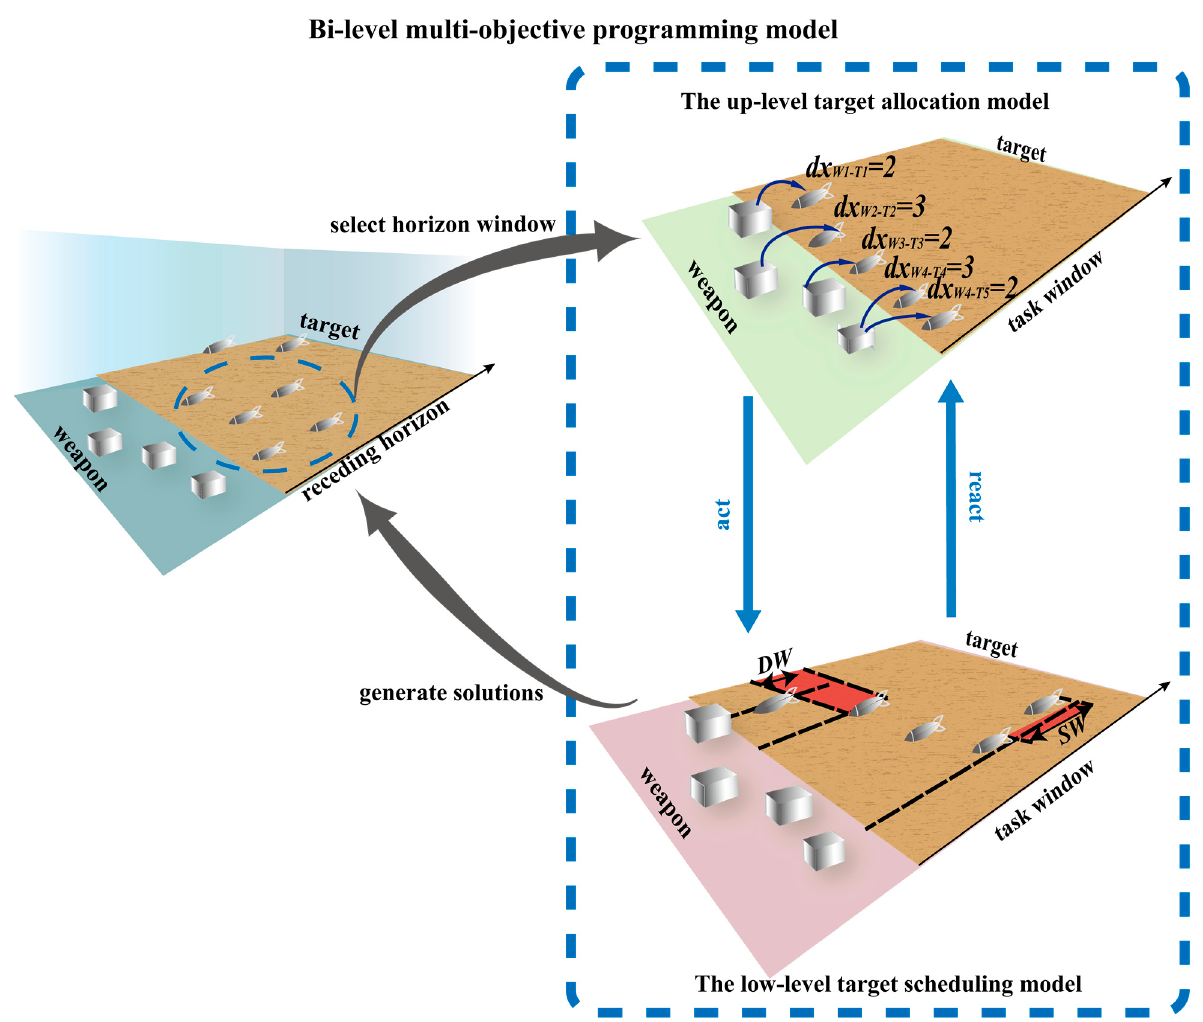
Figure 3. Bi–level multi–objective programming model.